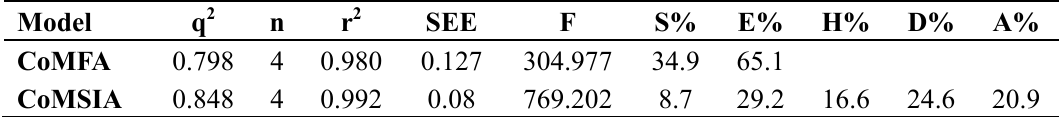
Table 2. Statistical parameters of CoMFA and CoMSIA models for the training set based on the molecular